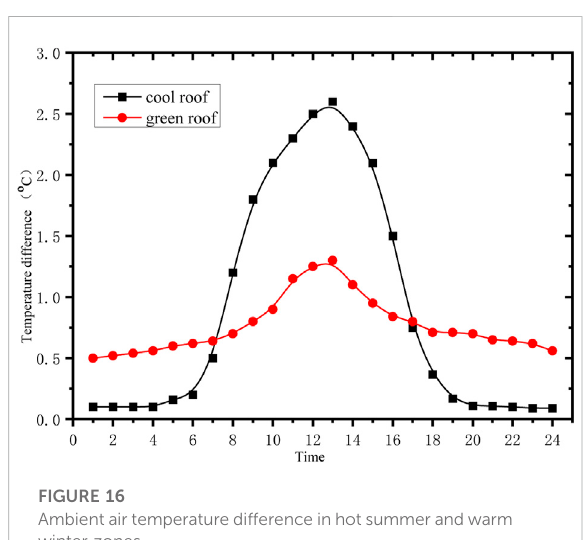
FIGURE 14 Whole day cooling load for hot summer and cold winter zones.